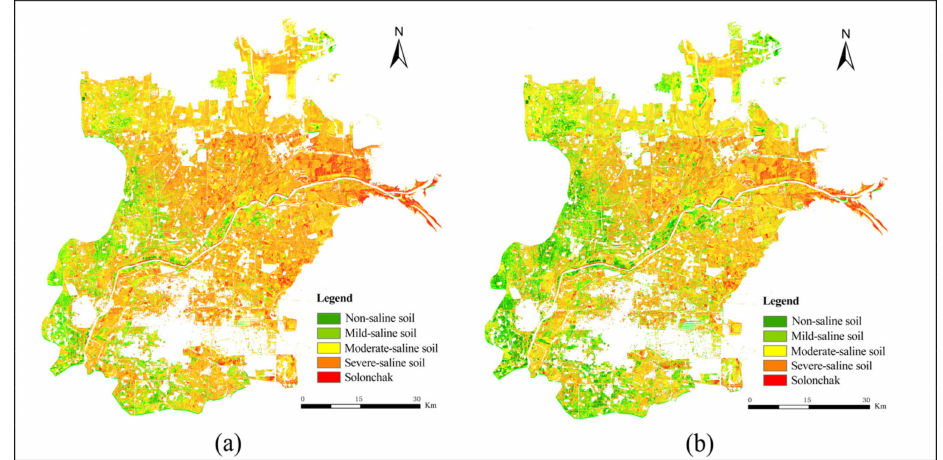
Figure 9. ( a ) Spatial distribution of soil salt content in the study area in 2019. ( b ) Spatial distribution of soil salt content in the study area in